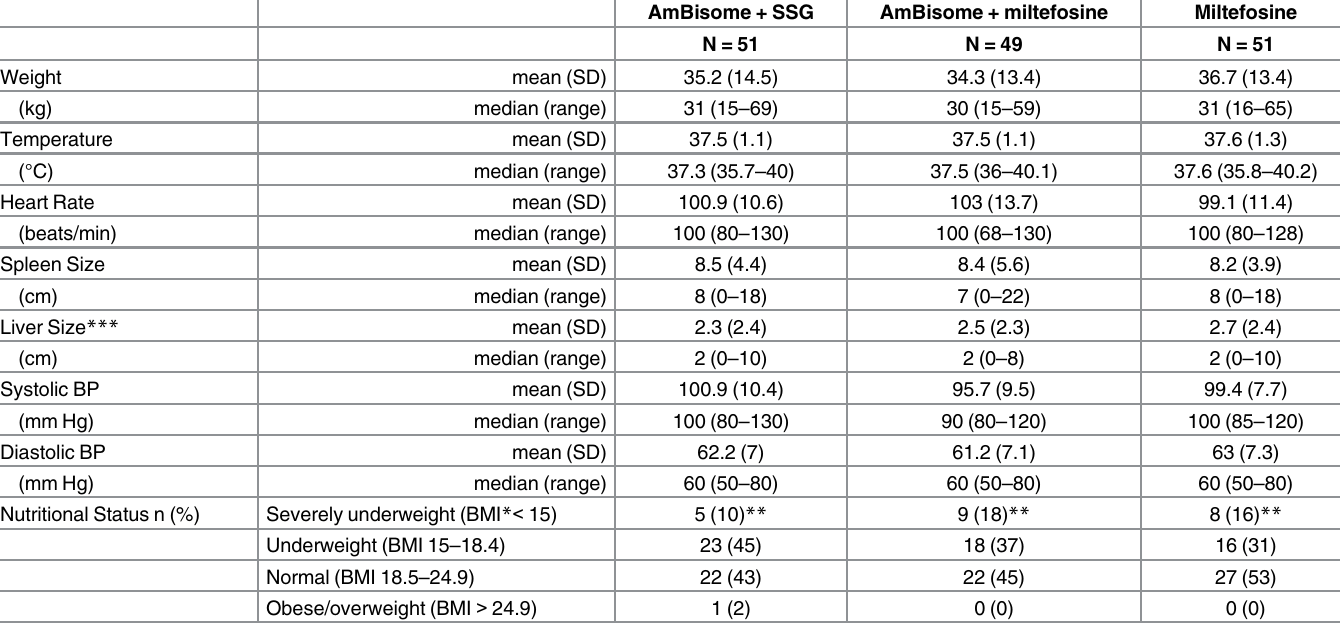
Table 2. Baseline biological markers.